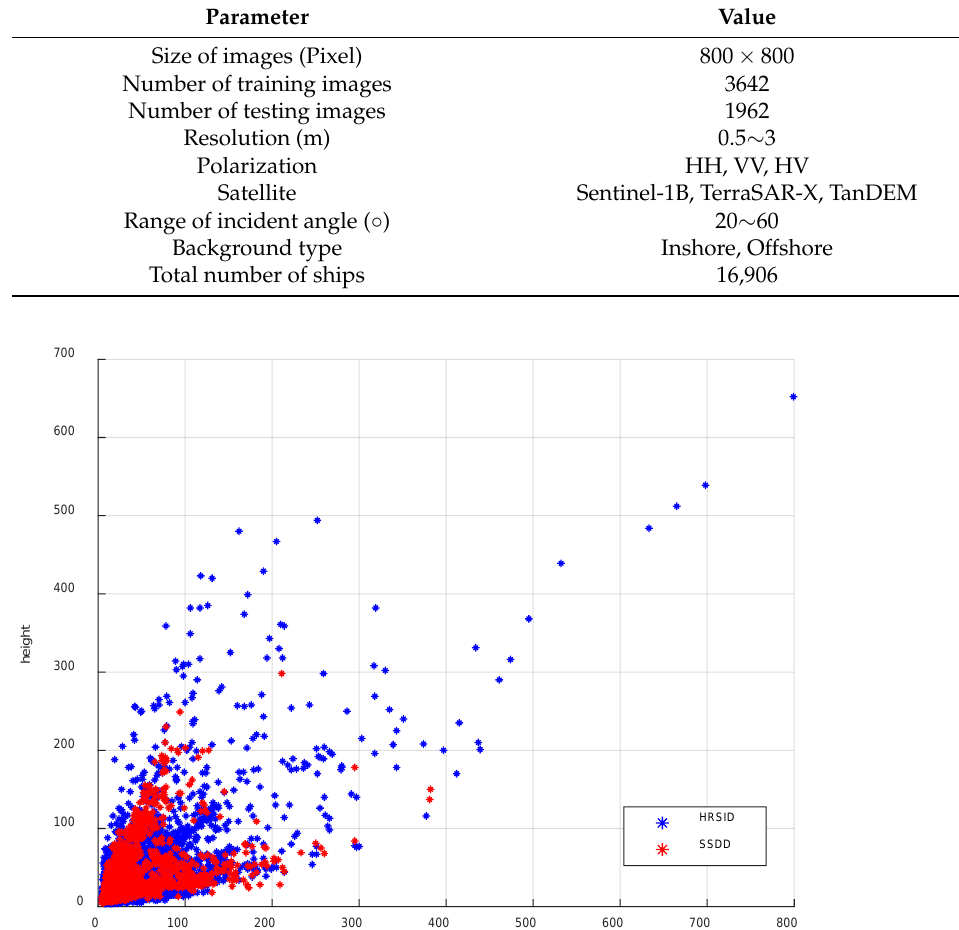
Table 1. The main parameters of HRSID.